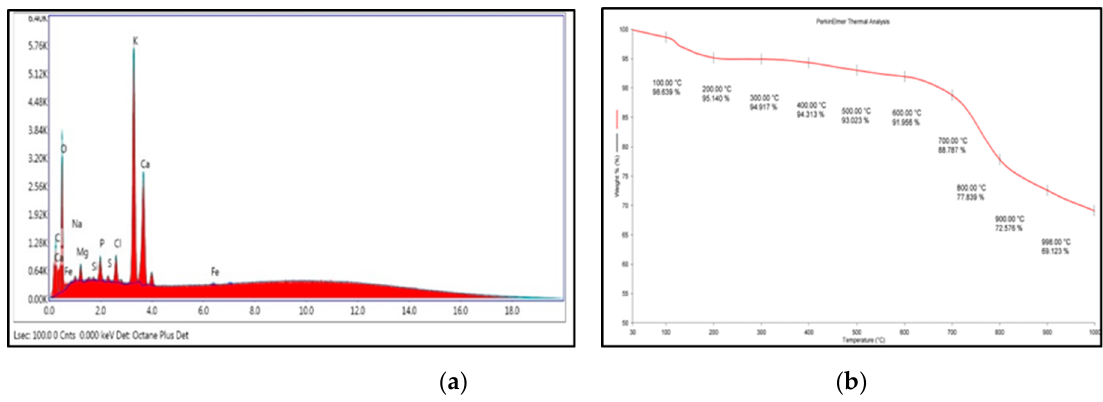
Figure 2. ( a ) FT ‐ IR spectra of OPA ( b ) XRD data of OPA, ( c ) N 2 adsorption–desorption isotherm, and ( d ) Barrett ‐ Joyner ‐ Halenda (BJH) pore size distribution analysis.